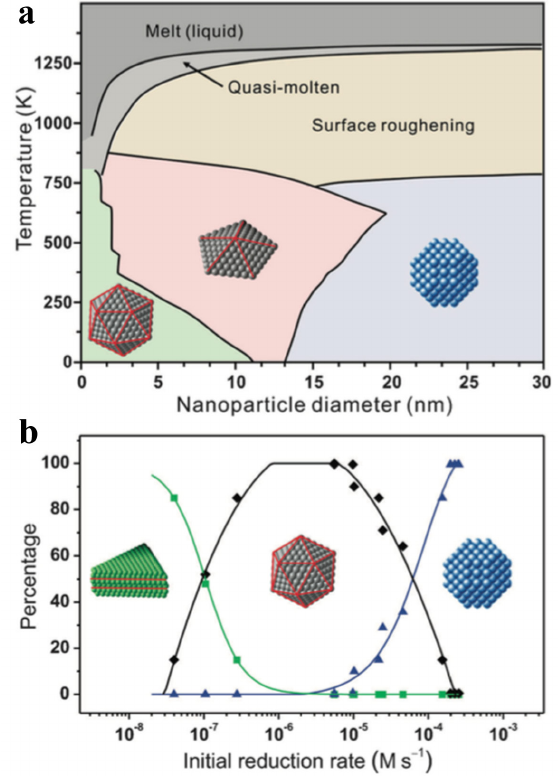
Figure 8 - Thermodynamic and kinetic approaches to controlling the internal structure of seeds. a) Phase diagram of Au seeds as a function of temperature and nanoparticle size; b) Population of Pd nanocrystals as a function of the initial reduction rate, displaying plates with stacking faults (orange), multiply twinned icosahedra (purple), and single- crystal cuboctahedra (blue). Adapted with permission from refs (Barnard et al. 2009, Wang et al. 2015) Copyright 2009 and 2015 American Chemical Society,